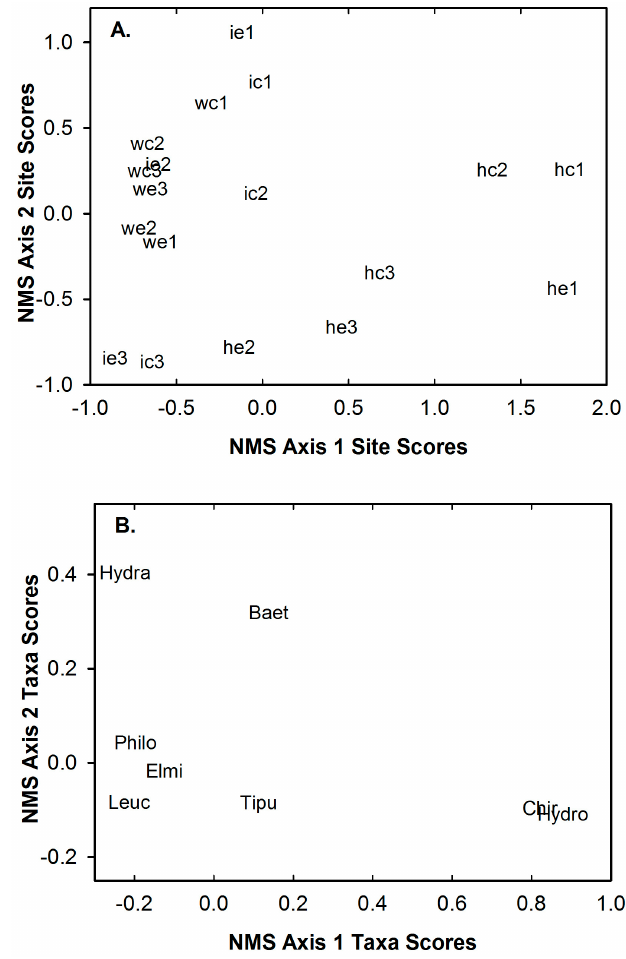
Figure 1. Site scores ( A ) and taxa scores ( B ) from the non-metric multidimensional scaling of the eight most common macroinvertebrate taxa captured one day before, immediately after and one day after experimental substrate disturbance in control and experimental riffles within three agricultural headwater streams of upper Alum Creek, 5–14 June 2015. The two letter